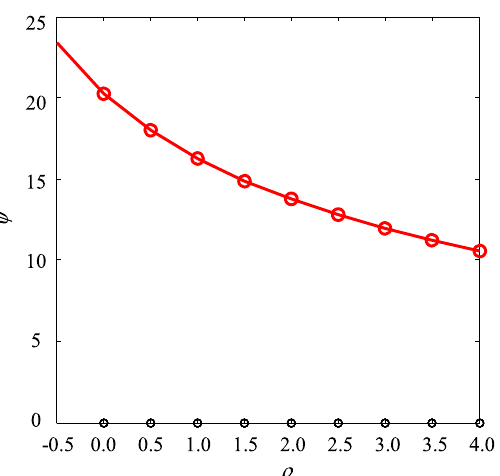
Fig. 9 Auto users’ travel time saving against transit users’ (in monetary units per